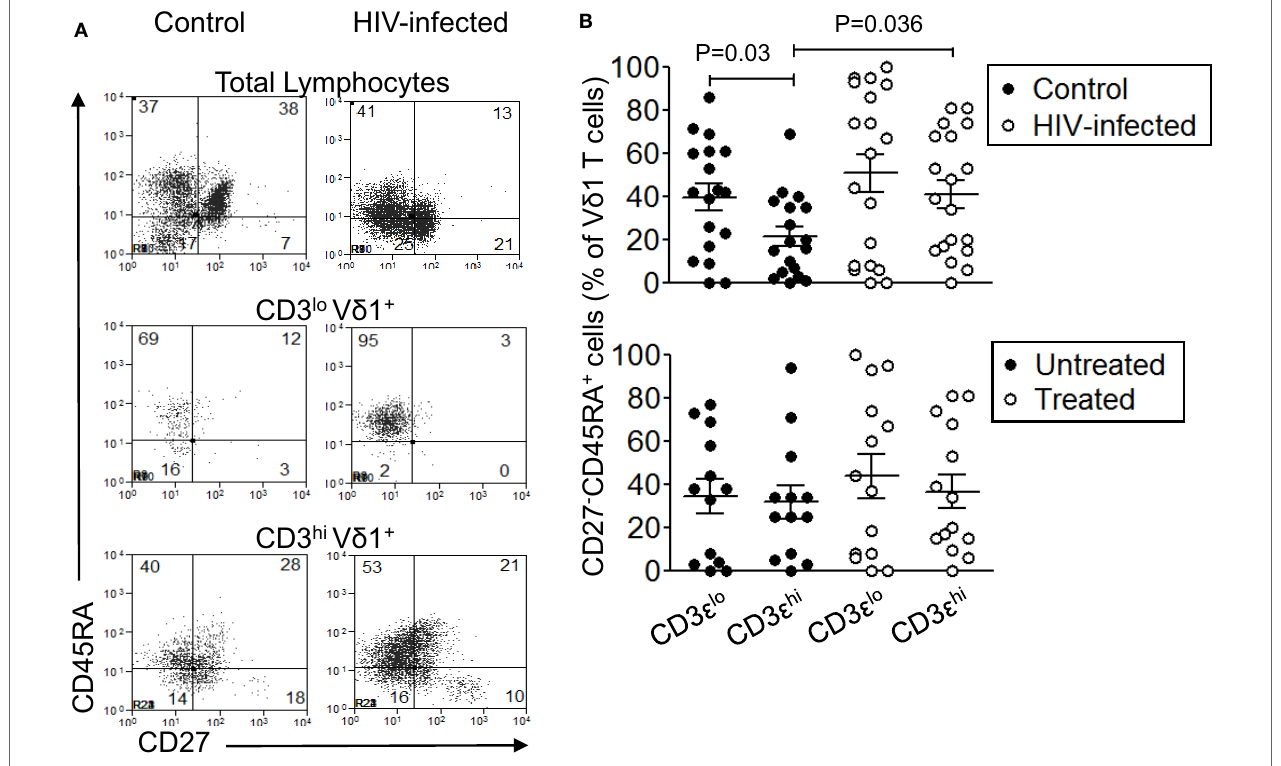
FigUre 6 | Significant proportions of CD3 ε lo V δ 1 T cells have terminally differentiated (TD) phenotypes. Peripheral blood mononuclear cell (PBMC) from 19 patients with human immunodeficiency virus (HIV) infection and 18 control subjects were enriched for γδ T cells using magnetic bead separation, stained with monoclonal antibodies specific for CD3 ε , V δ 1, CD45RA, and CD27, and analyzed by flow cytometry. (a) Representative flow cytometry dot plots showing CD45RA and CD27 expression by total lymphocytes (upper panels), CD3 ε lo V δ 1 T cells (center panels), and CD3 ε hi V δ 1 T cells (bottom panels) in a control subject (left panels) and a patient with HIV infection (right panels). (B) Scatter plots showing the frequencies of CD3 ε lo and CD3 ε hi V δ 1 T cells from the patients and controls (upper graph) that expressed TD (CD45RA + CD27 − ) phenotypes. The lower graph shows the frequencies of CD3 ε lo and CD3 ε hi V δ 1 T cells from untreated ( n = 13) and antiretroviral therapy-treated ( n = 14) patients who expressed TD phenotypes. Groups were compared using the Mann–Whitney U